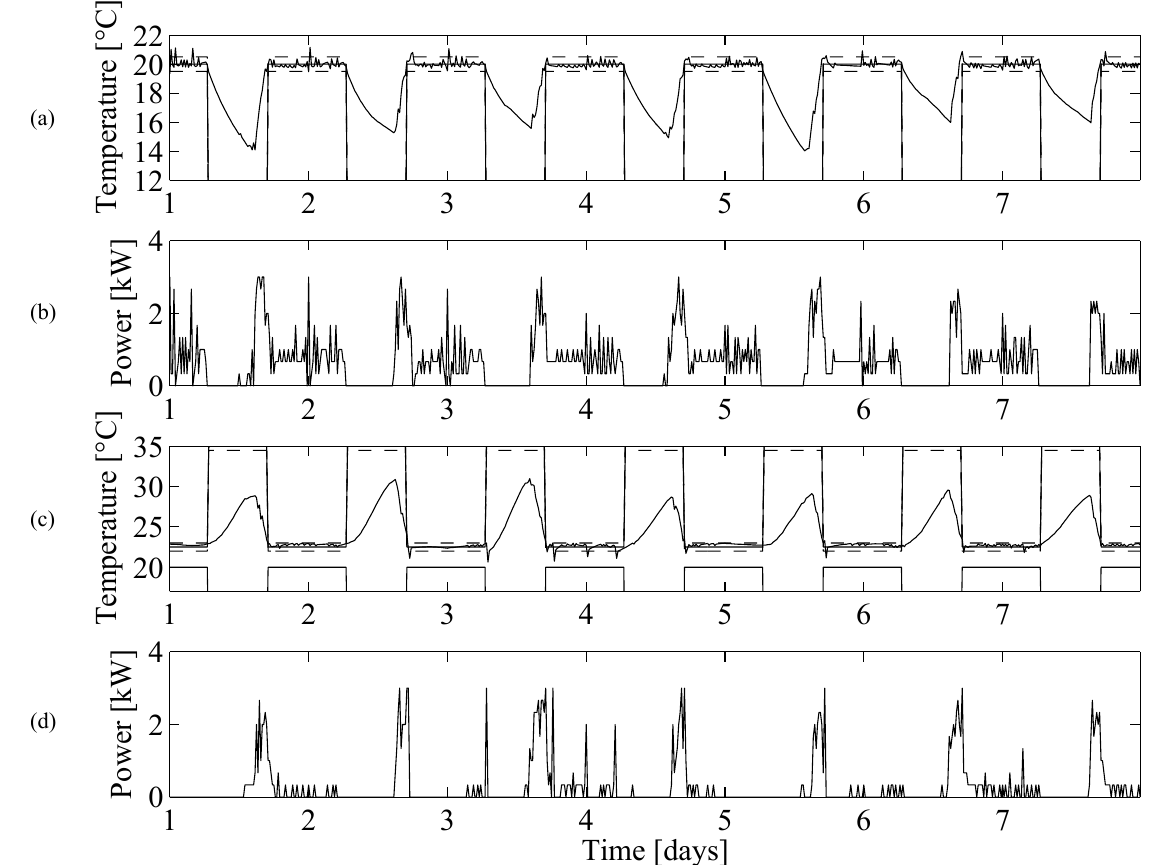
Figure 6. Indoor temperature and power consumption of the learning agent with set-back strategy during seven winter ( a , b ) and summer days ( c , d